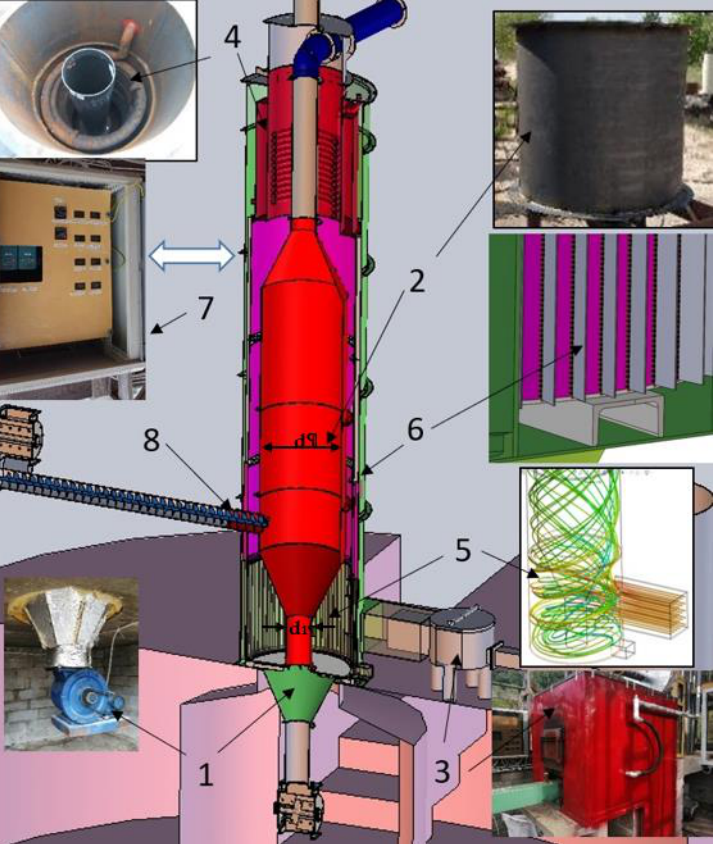
Figure 2. The fountain dryer modified parts. 1 — dirt separator; 2 — drying chamber segment; 3 — furnace for burning waste; 4 — water heat exchanger; 5 — direction of exhaust gases in the drying chamber; 6 — ribbed heating surface; 7 — measuring cabinet; 8 — variable pitch screw feeder.